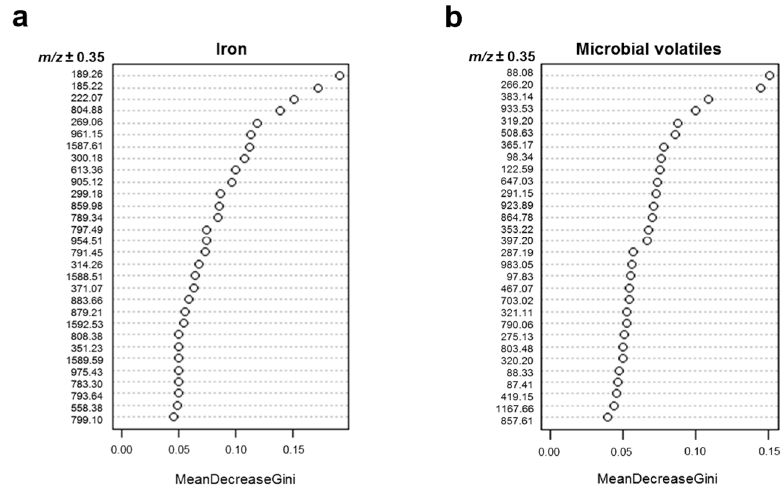
Figure 4. Ion importance ranking obtained by Random Forest model for differentiating between sample treatments with DLI-ESI mass spectra data. The thirty most important ions are shown for discriminating between Fe growth conditions ( a ) and the effect of microbial volatiles ( b ). Ntrees = 500, OOB error = 0% for Fe growth conditions and 43.75% for volatiles.